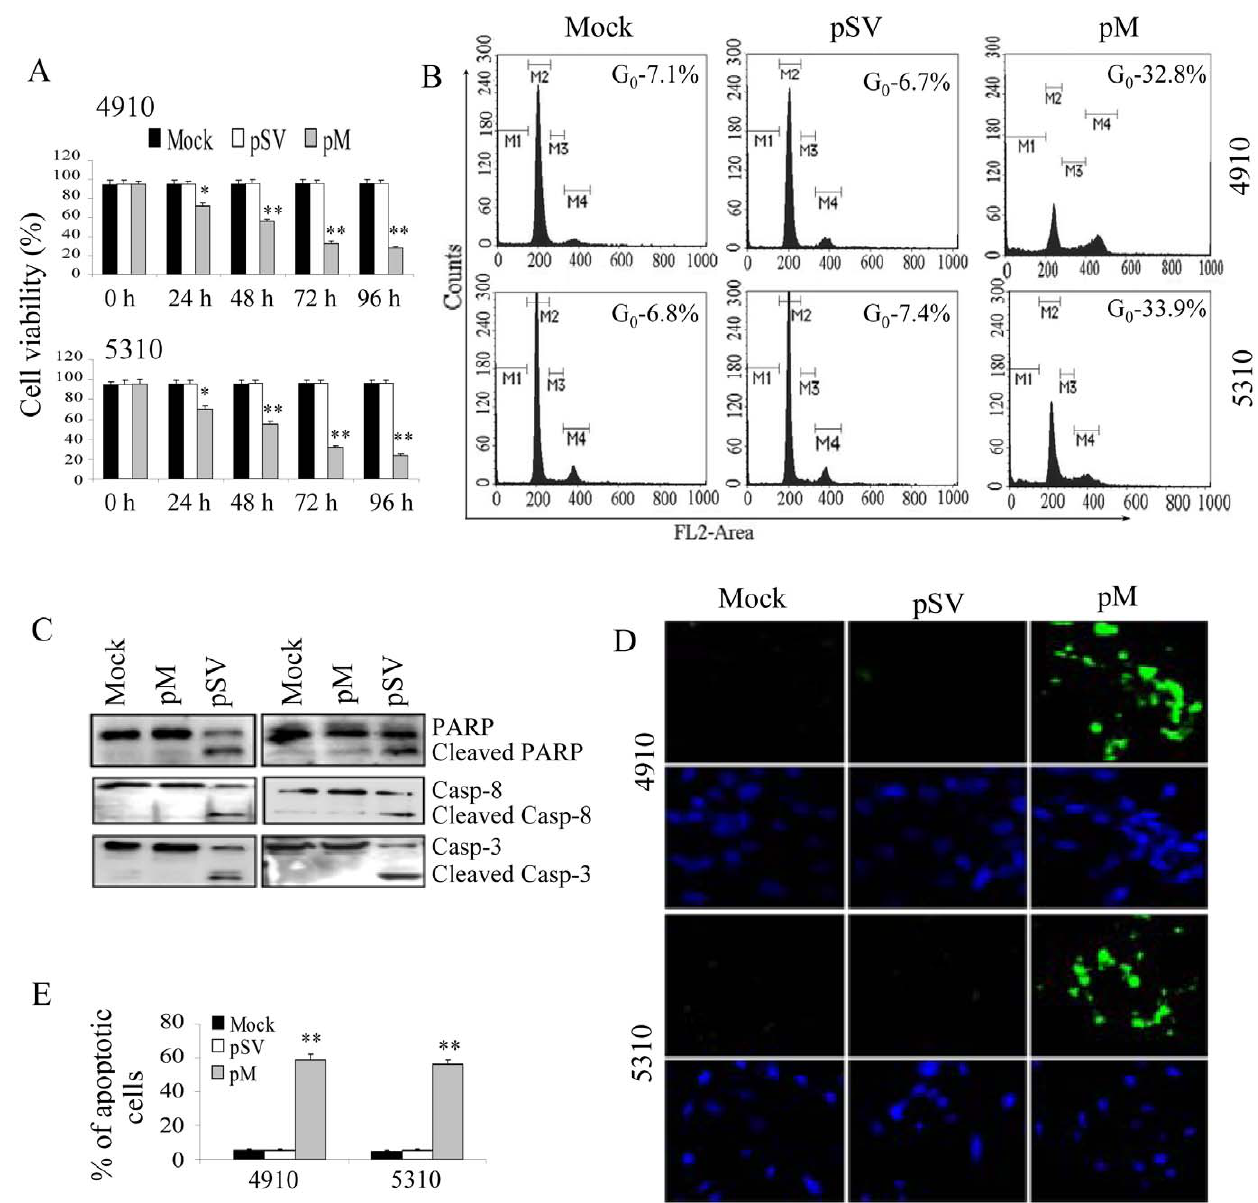
Figure 2. MMP-2 RNA interference inhibited proliferation and induced apoptosis in human xenograft cell lines. A. 4910 and 5310 cells were treated with mock, pSV and pM for different time points (24 h, 48 h, 72 h and 96 h) and subjected to MTT cell viability assay. Data were represented as mean 6 SE of three independent experiments. The significant difference among different treatments was represented by ‘‘*’’, at p # 0.05 and ‘‘**’’, at p , 0.01. B. Cell cycle distribution in 4910 and 5310 cells 72 h after mock, pSV and pM treatments. DNA content was analyzed by flow cytometry as described in Materials and Methods. The percentage of apoptotic population in cells was represented as G 0 in histograms. Three individual experiments were conducted to confirm similar results. C. Whole cell lysates were prepared from mock, pSV- and pM-treated cells and subjected to Western blotting to check the cleavage of PARP, caspases-8 and caspases-3. Blots are representative of 3 independent experiments. D. Xenograft cell lines 4910 and 5310 were seeded in chamber slides and transfected with pSV and pM after 24 h for 72 hours at the end of which the cells were fixed in 4% paraformaldehyde and subjected to TUNEL assay. E. Percentage of apoptotic cells was plotted in corresponding bar diagrams with values representing mean 6 SE. and significant difference among treatments is represented by ‘‘**’’, p ,